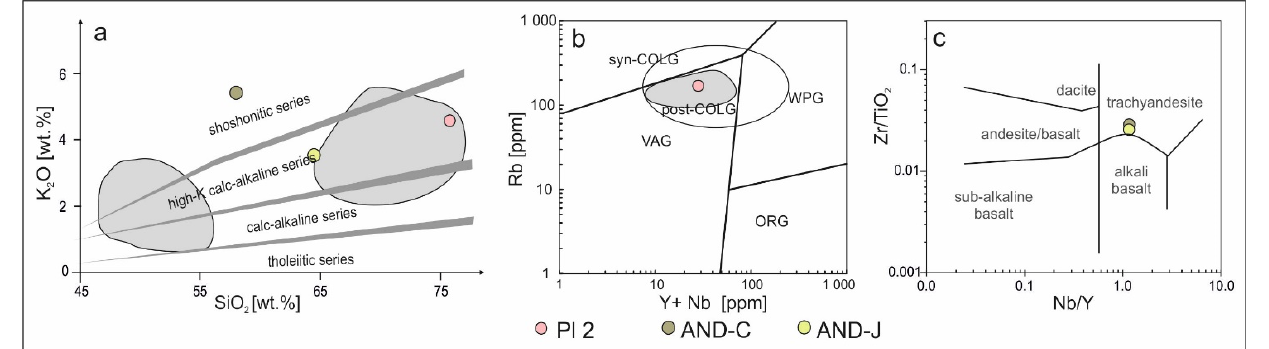
Figure 3. The Pluskawka microgranite and andesite plotted on: ( a ) K 2 O versus SiO 2 classification diagram after using method presented in [34]; ( b ) discrimination diagram using method presented in [35]; ( c ) discrimination diagram using method presented in [36]. Gray areas are data from Mikulski et al. [37].